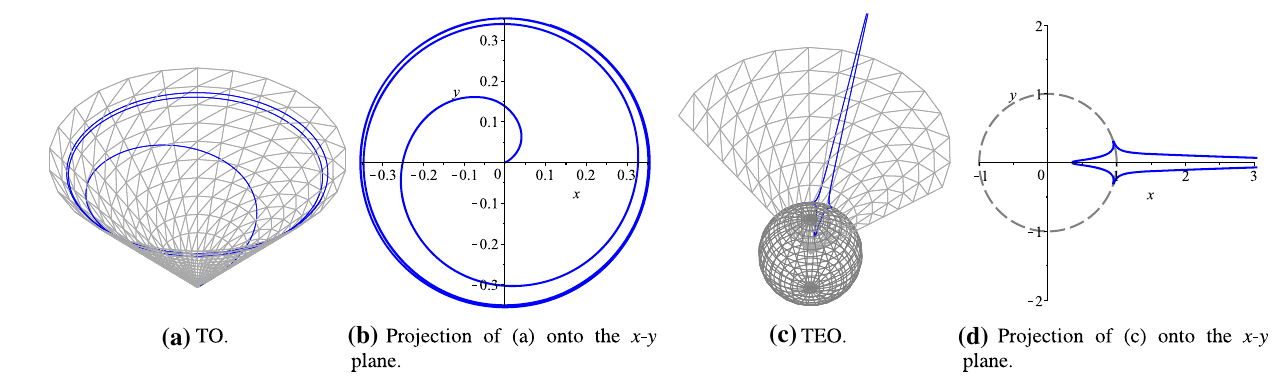
circle show the horizon at R = 1. The corresponding effective potential of the r motion is very similar to the one shown in Fig. 5b